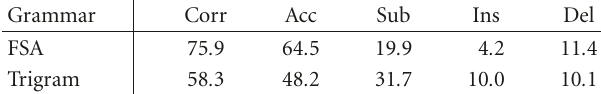
Table 2: Word recognition/error rate [%].